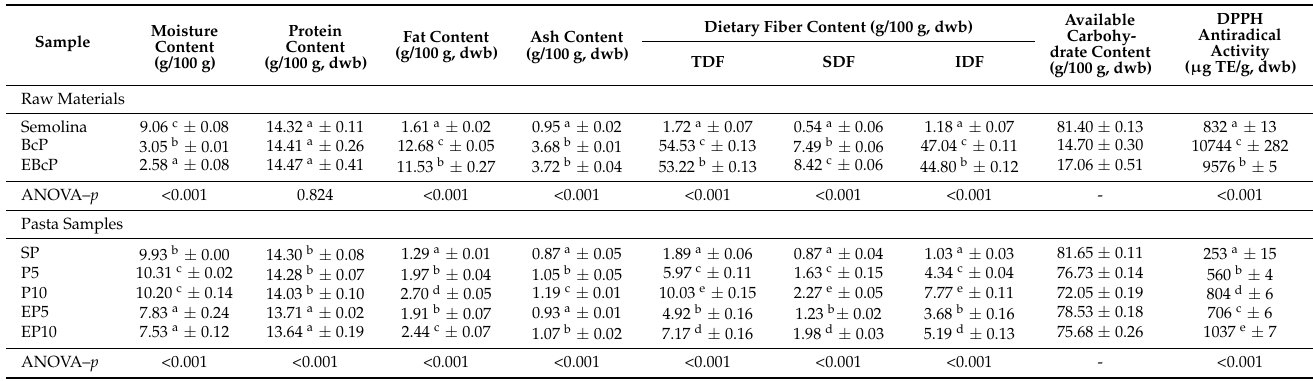
Table 1. Proximate composition of raw materials and pasta